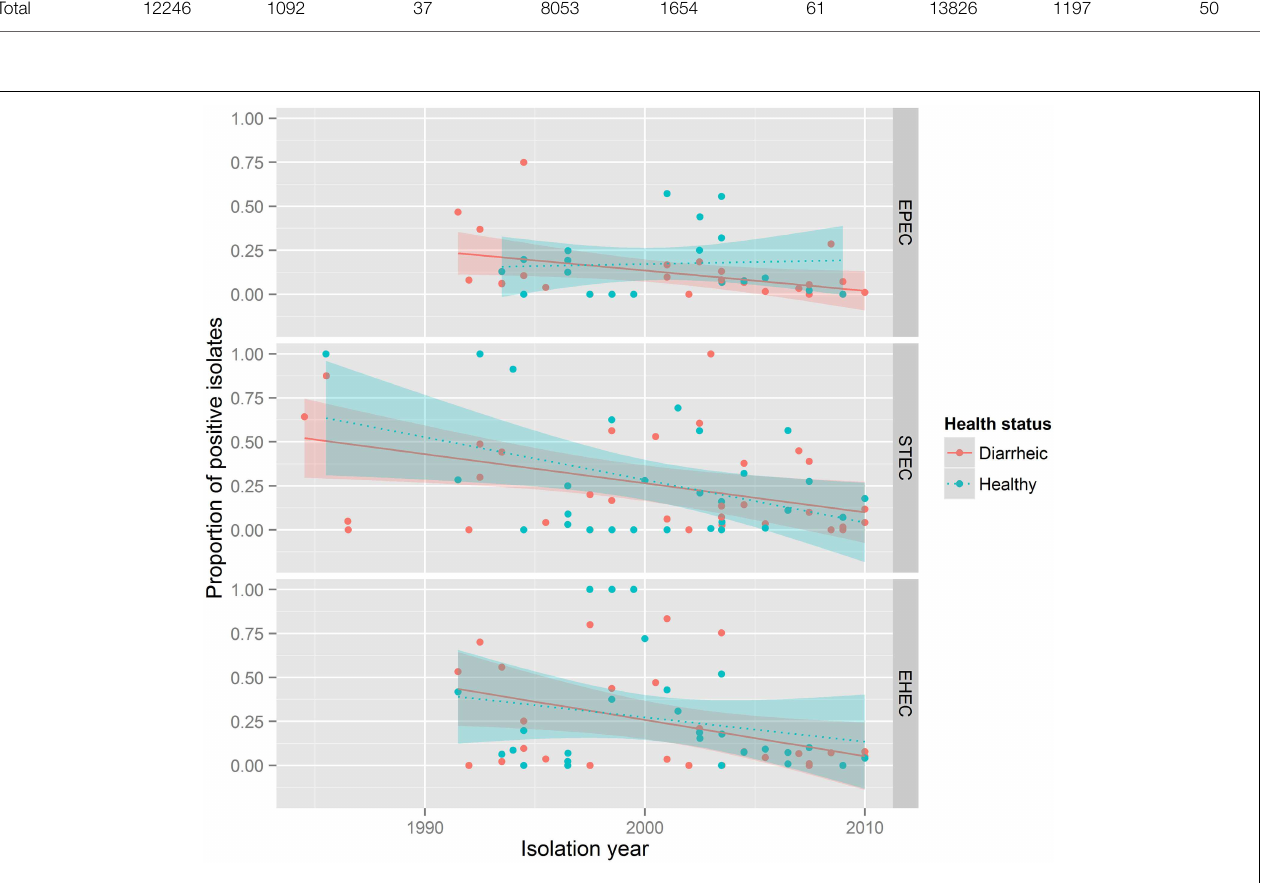
lines show general tendencies by approximating the relationship between the year of isolation and the prevalence of a pathotype using a linear model y = ax + b. The shaded areas around lines represent confidence